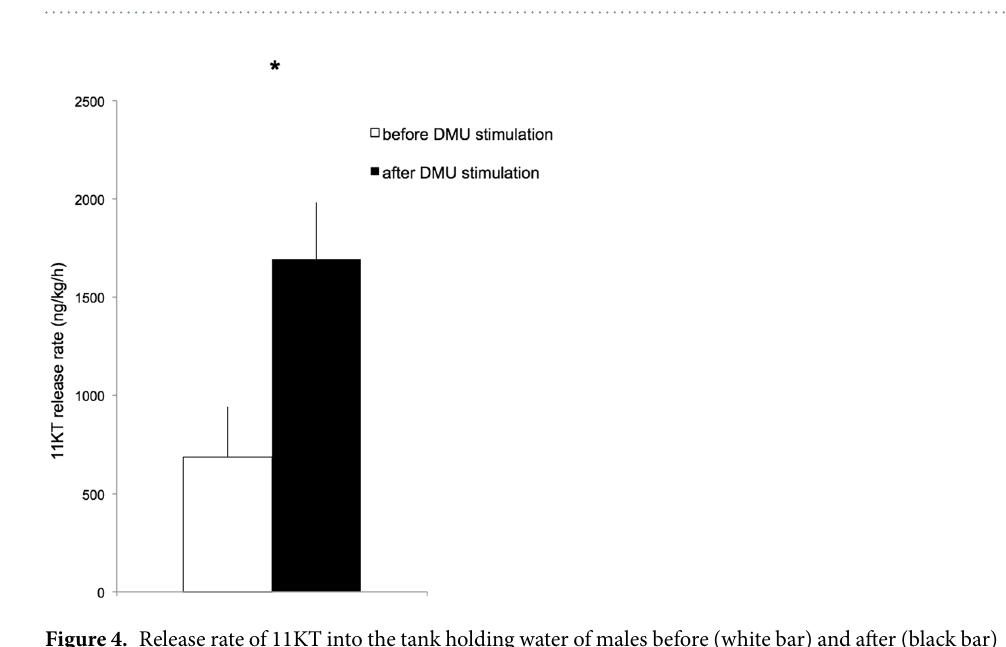
Figure 3. Changes ( Δ ) in urinary 11KT levels (as measured immediately after the mirror test and subtracted by the urinary 11KT levels measured 24 h before) in control (white bar) and DMU (black bar) stimulated males. N DMU = 13, N control = 6. Significant differences at P < 0.05 are marked with * . See text for details.